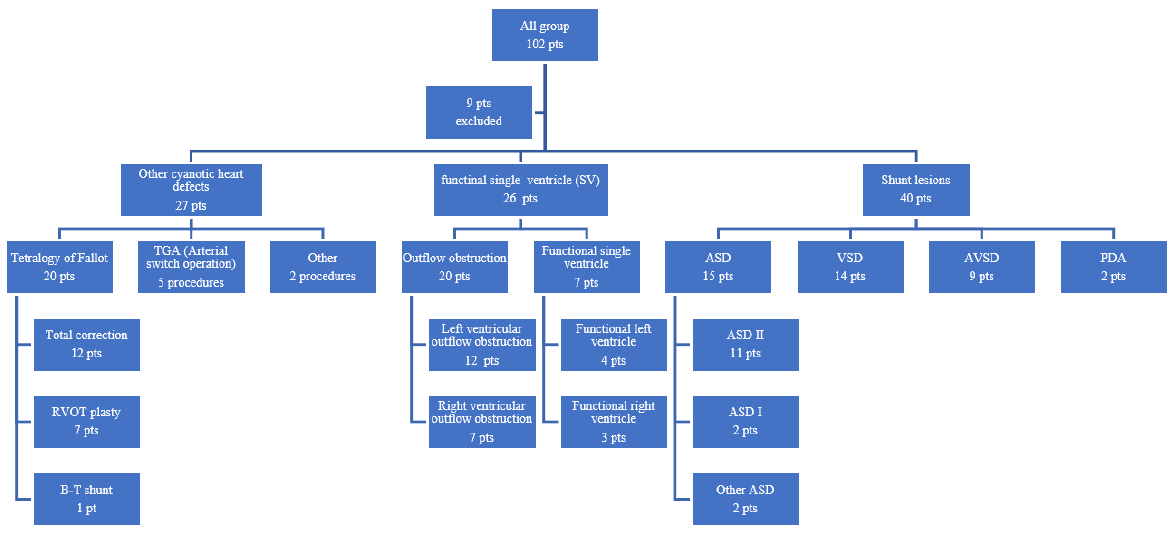
Figure 1. Flow chart. Abbreviations: ASD — atrial septal defect, ASD 1 — atrial septal defect type 1, ASD 2 — atrial septal defect type 2, AVSD — atrioventricular septal defect, pt — patient, pts — patients, RVOT — right ventricle outflow tract, SV — functional single ventricle.